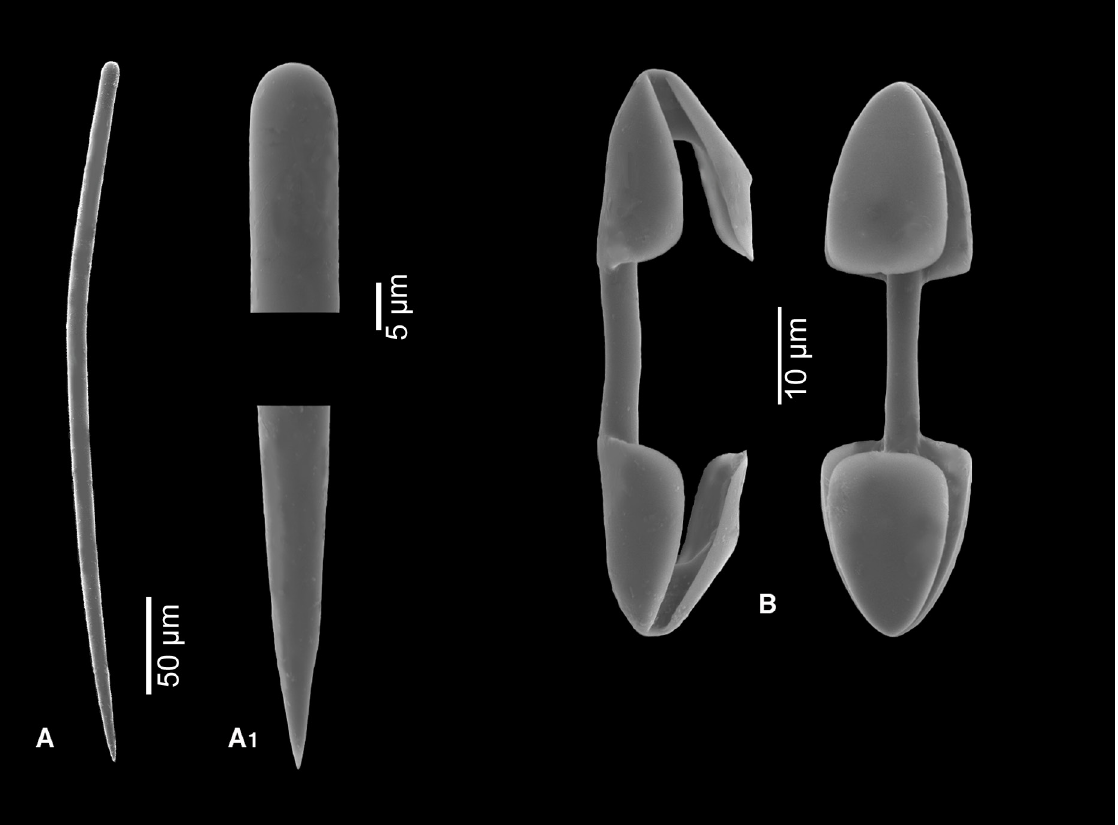
Fig. 3. Amphilectus utriculus sp. nov., Holotype ZMA Por. 22592, SEM images of spicules. A . Styles. . Detail of the apices. B . Palmate isochelae in side and ventral A 1